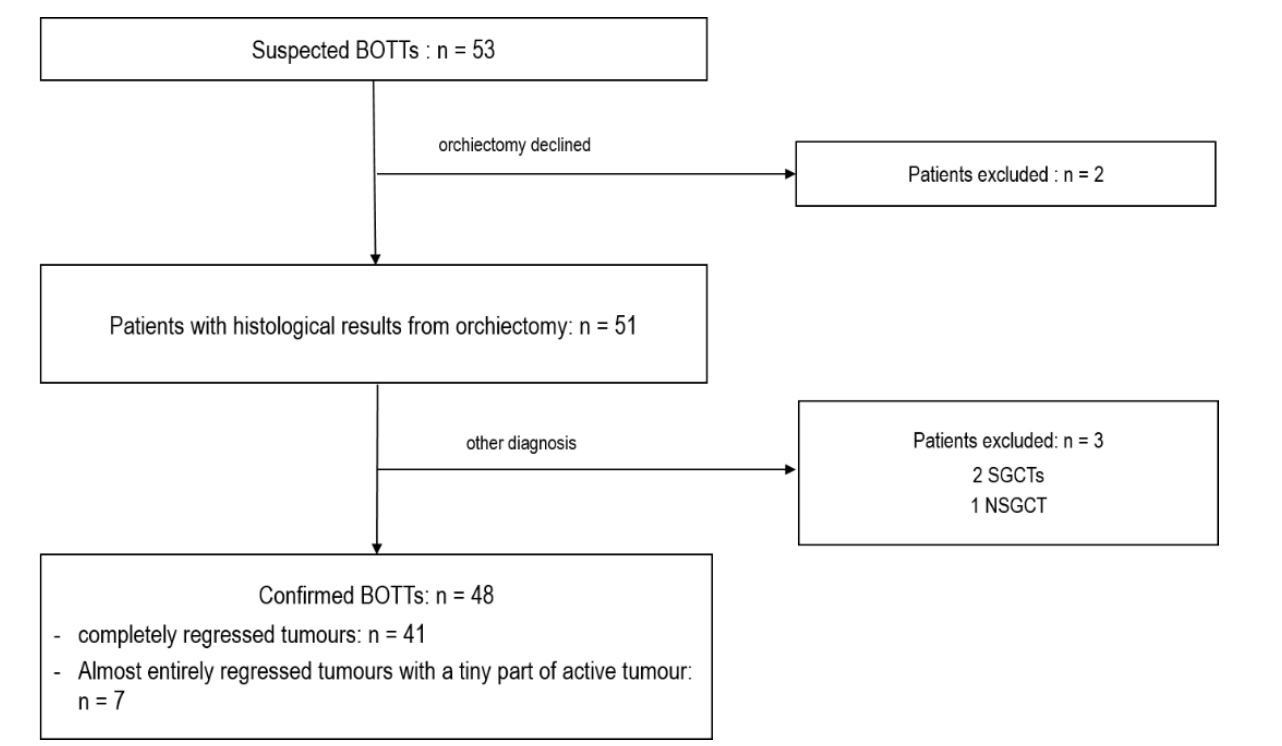
Figure 1. Flow chart of patient selection.